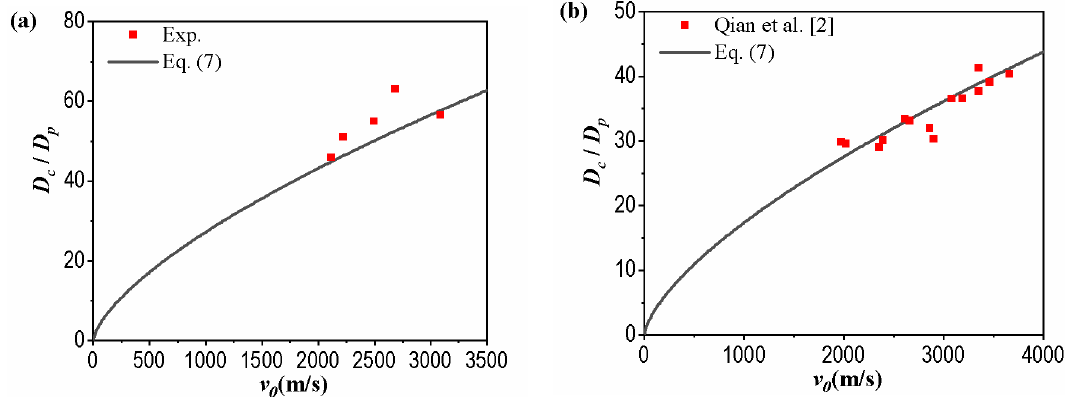
Figure 17. Experimental and predicted crater diameters: ( a ) present experiment, ( b ) Qian et al. 2.